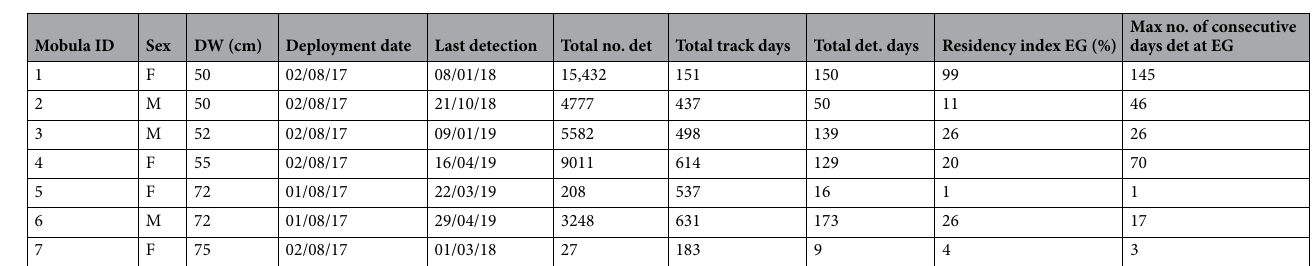
Table 1. Summary of acoustic tag deployments on 4 neonates (1–4 ID) and 3 juveniles (5–7 ID) of M. munkiana at Ensenada Grande (EG), Espiritu Santo Archipelago in 2017. Dates are given as d/mo/yr. DW, disc width; no. det, number of detections; det,